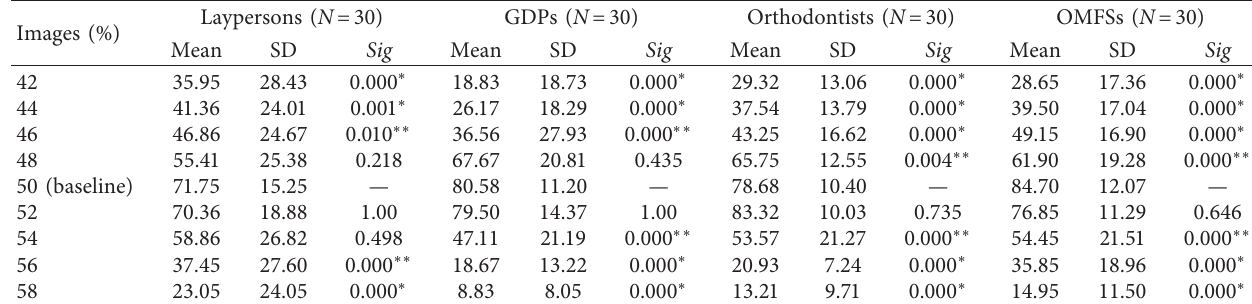
Table 3: Means and SDs of the esthetic values for the baseline LAFH image and the manipulated decreased and increased LAFH images as perceived by the four raters